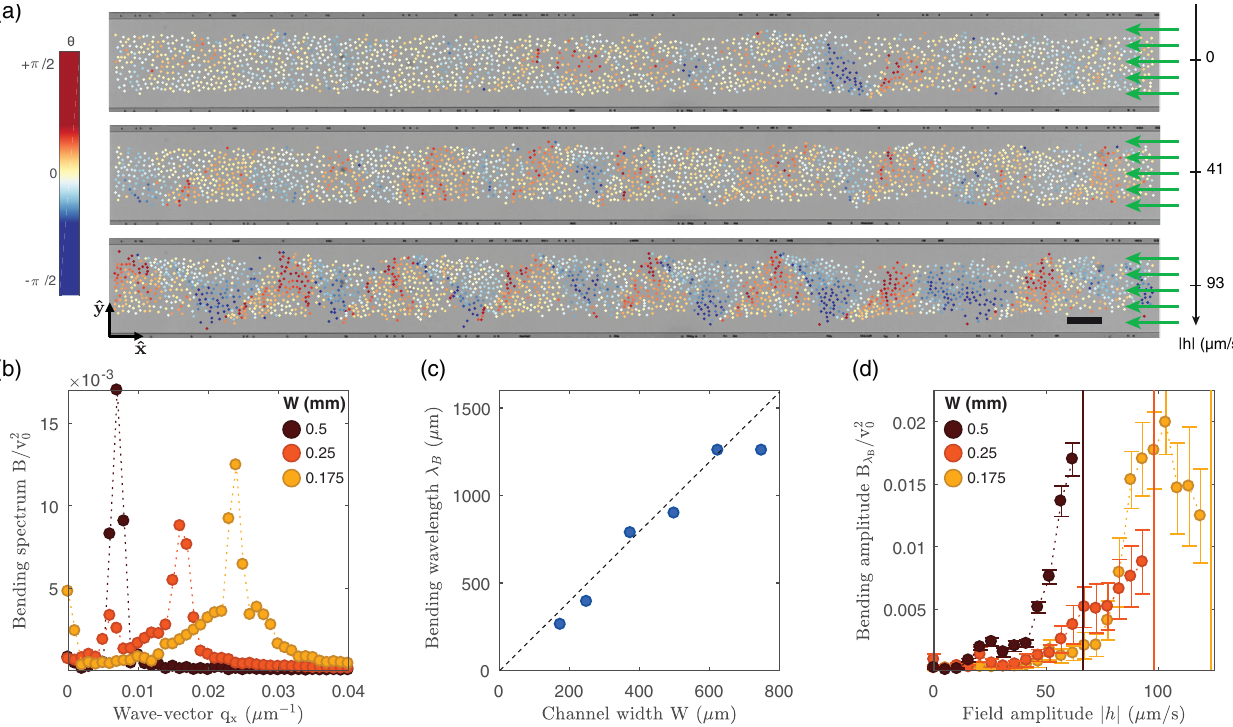
FIG. 3. Bending deformations of a polar liquid flowing against an external field. (a) Snapshots of polar liquids flowing against external fields of increasing magnitude. The color indicates the angle of the instantaneous velocity of the rollers θ . As j h j increases, a bending- oscillation pattern grows. W ¼ 0 . 25 mm. The scale bar represents 100 μ m. (b) The time-averaged spectra of the bending modes along q ¼ ð q ; 0 Þ [ B ð q Þ ¼ hj v ð q ; t Þj 2 i y x x x t ] are plotted for three different confinement widths: taken just before flow reversal: h ¼ 62 , 93, 119 μ m = s, respectively. λ ¼ 2 W (dashed line). (d) Variations of the amplitude of the bending mode at q ¼ 2 π = λ of λ with W . λ B B deformations at λ increase when increasing j h j . The vertical lines indicate the values of h B represent 1 sd (time